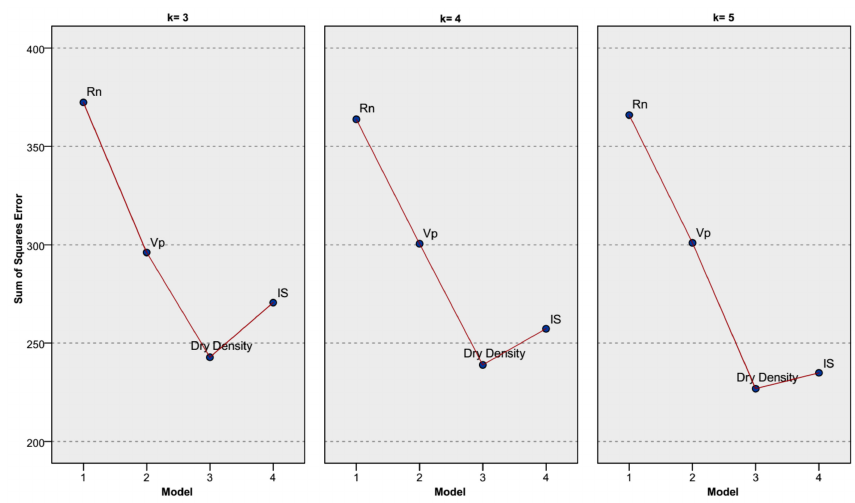
Figure 12. The relationship between the predictors and K selection for predicting the BI .